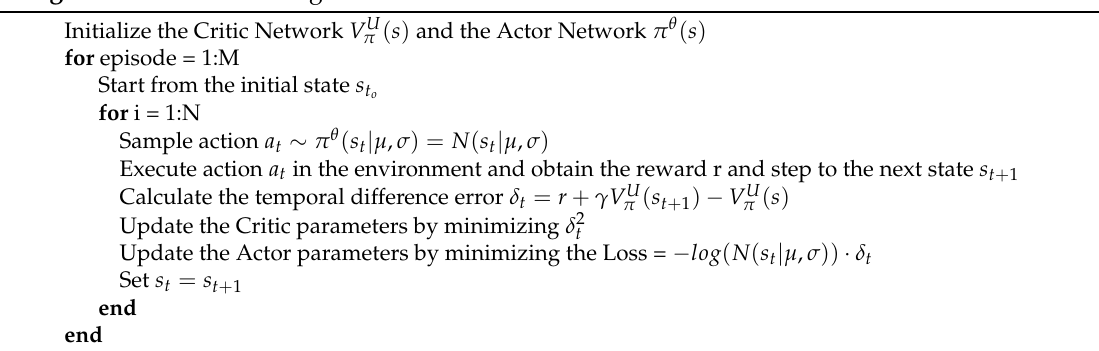
Algorithm 1: TD Advantage Actor